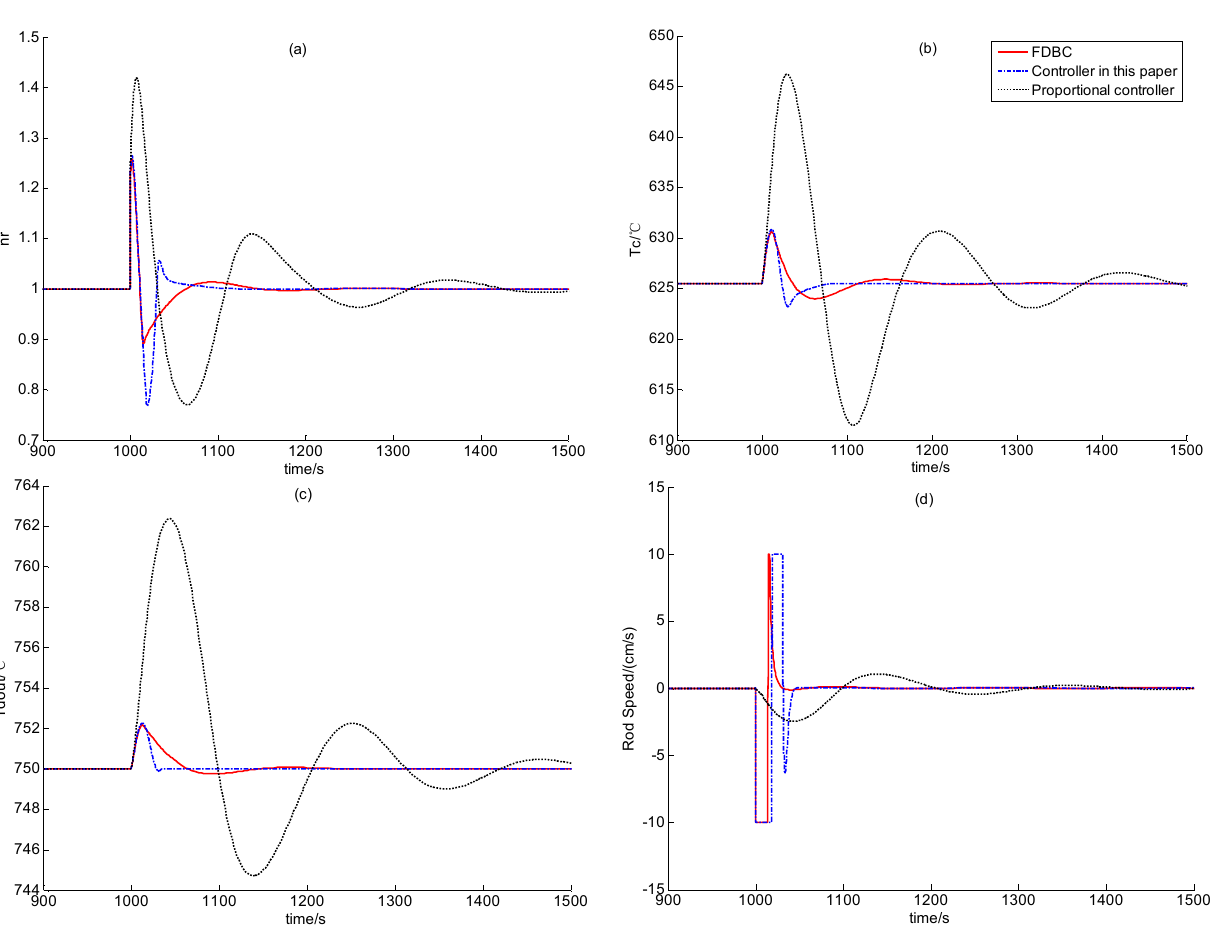
Figure 7. Simulation Results in Case